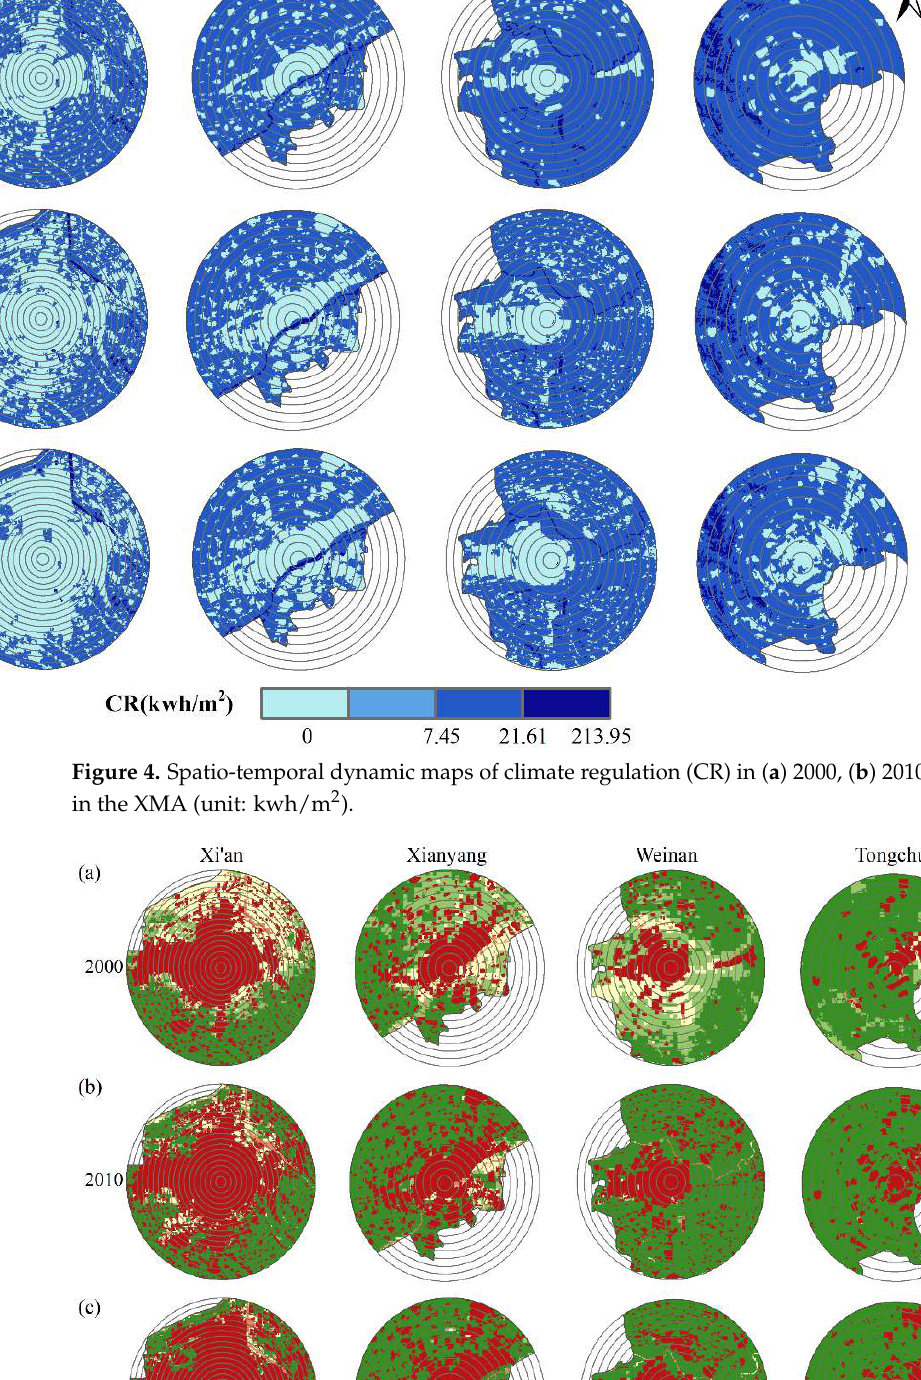
Figure 6. Spatio-temporal dynamic maps of recreation (R) in ( a ) 2000, ( b ) 2010, and ( c ) 2020 in the XMA (unit: m 2 per person).